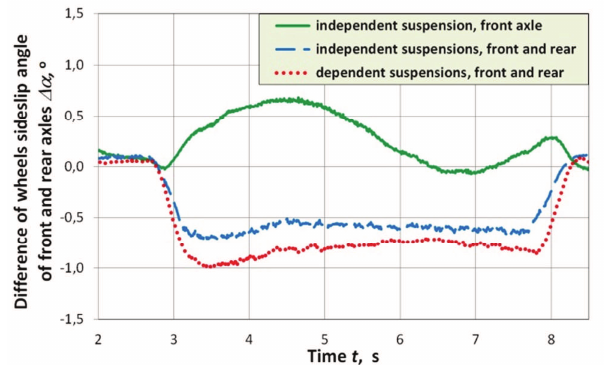
Fig. 14. The influence of roll angle f on the difference of wheels side slip angle of front and rear axles. [own research]